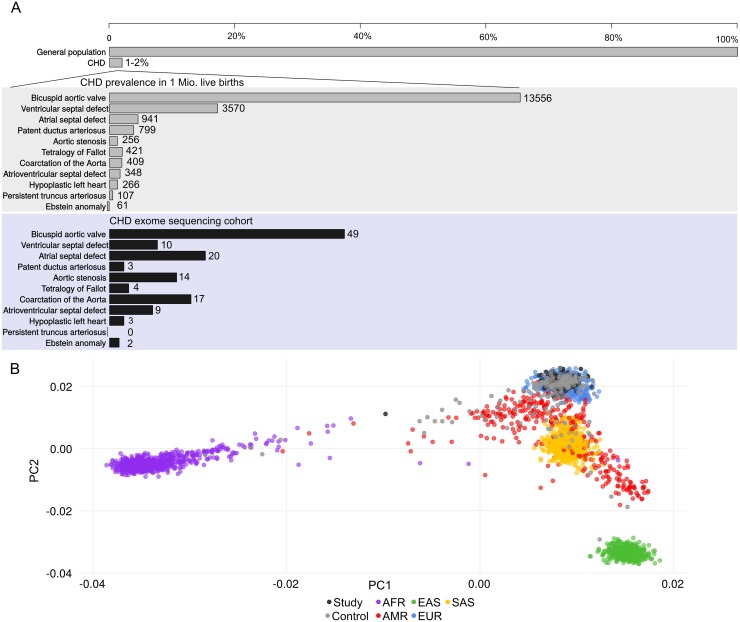
Overview of the study cohort.(A) Prevalence and phenotypes associated with CHD in the general population and in the presented cohort. The numbers highlighted in grey indicate the prevalence of CHD phenotypes in 1 million live births according to Fahed et al. [3]. The graph highlighted in blue represents the distribution of overlapping CHD phenotypes in our cohort, which show a similar distribution of what is expected from the general CHD population. (B) Principal component analysis of individuals from the French Canadian pediatric cohort presented in this study with 2504 individuals from the 1000 Genomes phase 3 release for the five human super populations (AFR: purple, AMR: red, EUR: blue, EAS:green, SAS:yellow). Study subjects (black dots) and controls (grey dots) predominantly cluster with individuals of European descent (blue dots).